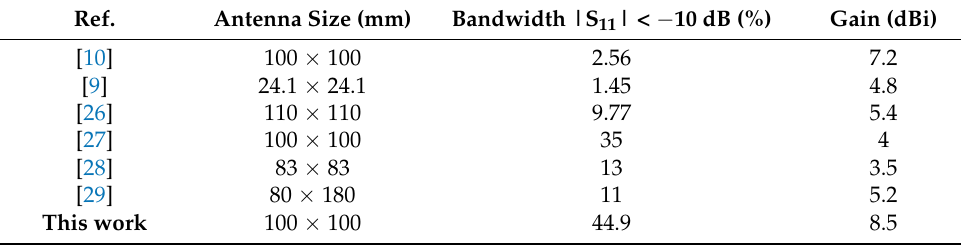
Table 2. Comparison of the proposed antenna with previous S-band patch antenna designs.